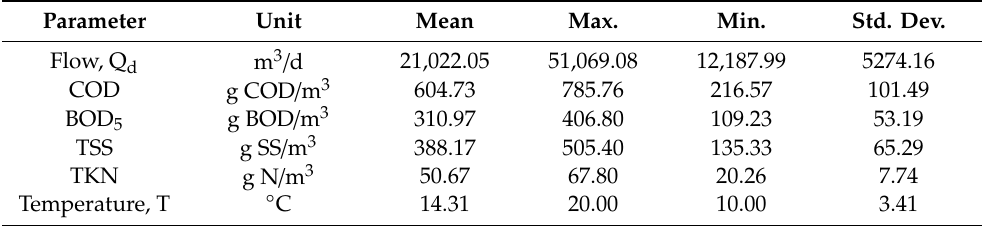
Figure 1. The layout of modelled activated sludge plant (representation from WEST ® software by DHI, Horsholm, Denmark); ASU_A, ASU_B—activated sludge units; CL_A, CL_B—final clarifiers; WAS—waste activated sludge; RAS—external recirculation; IRAS—internal recirculation. Table 1. Influent characteristics (daily, flow proportional